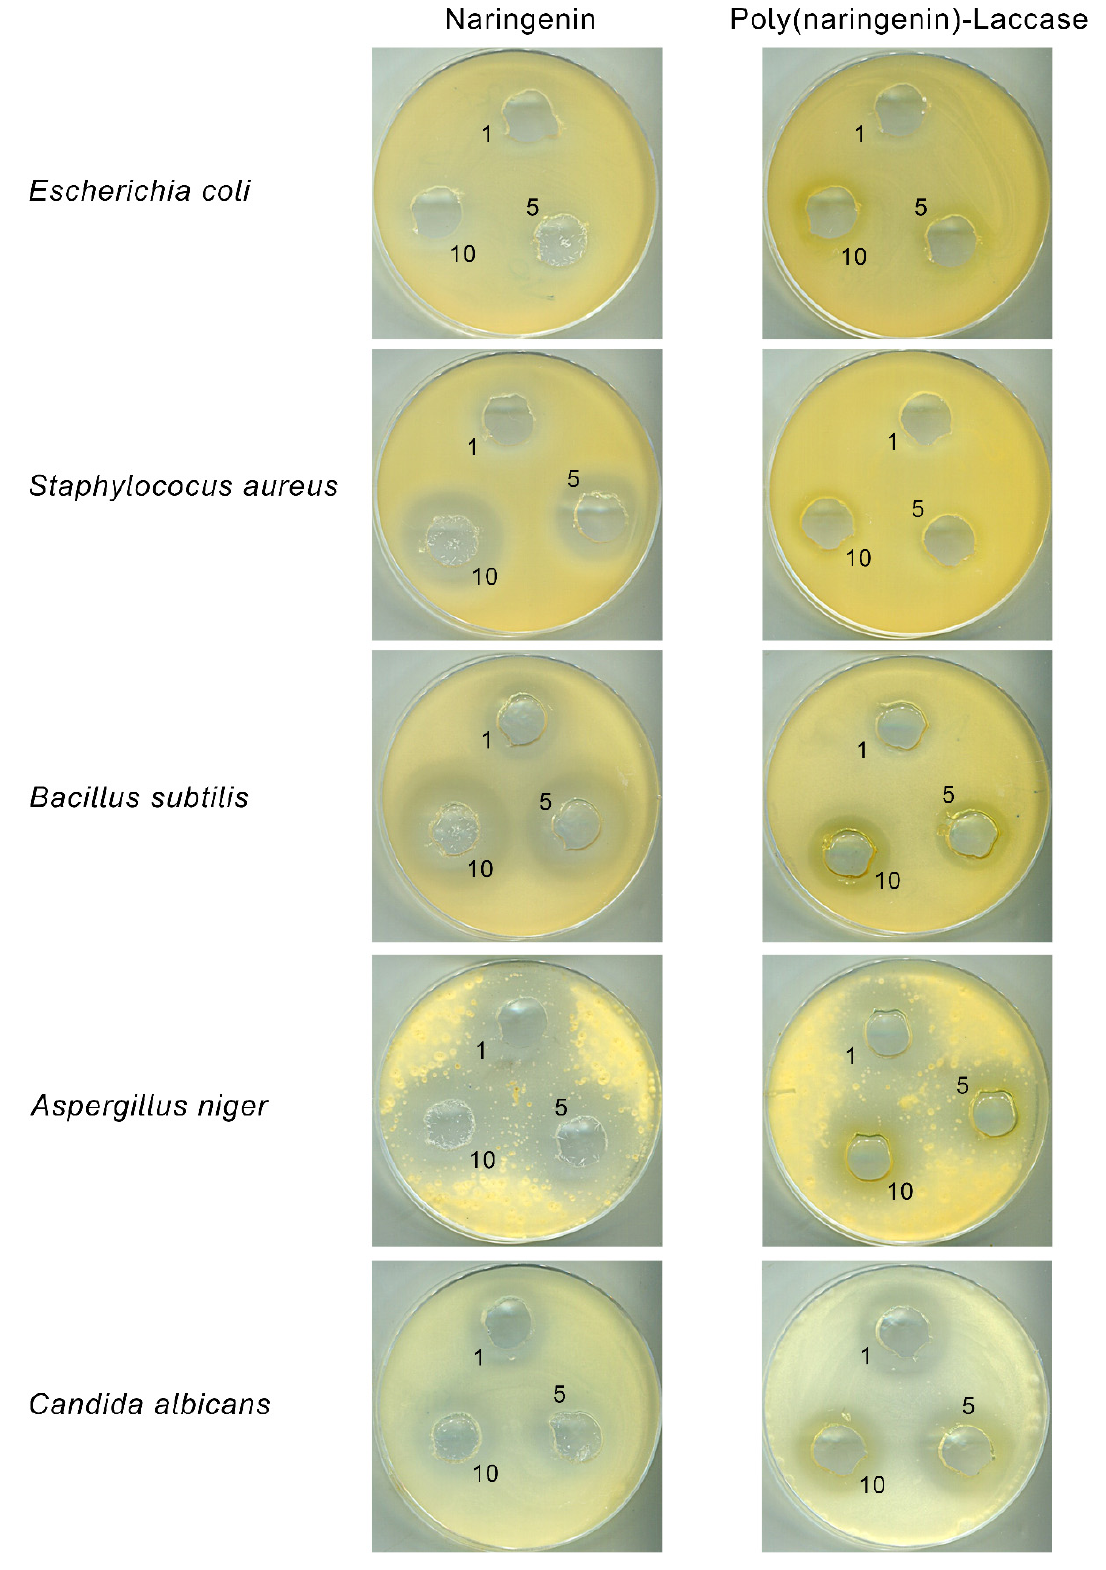
Figure 8. Photographic documentation of antimicrobial tests of naringenin and poly(naringenin)- laccase, where 1, 5, 10 means naringenin or poly(naringenin) concentration of 1 mg/mL, 5 mg/mL and 10 mg/mL.